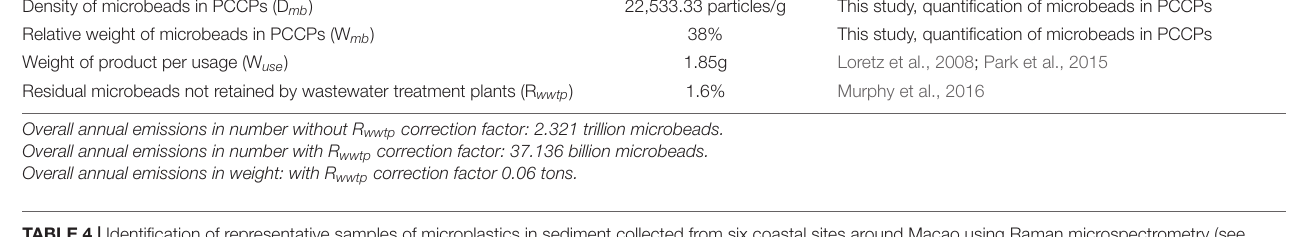
TABLE 4 | Identification of representative samples of microplastics in sediment collected from six coastal sites around Macao using Raman microspectrometry (see Figure 1 for the site abbreviation). Polymer type of microplastics